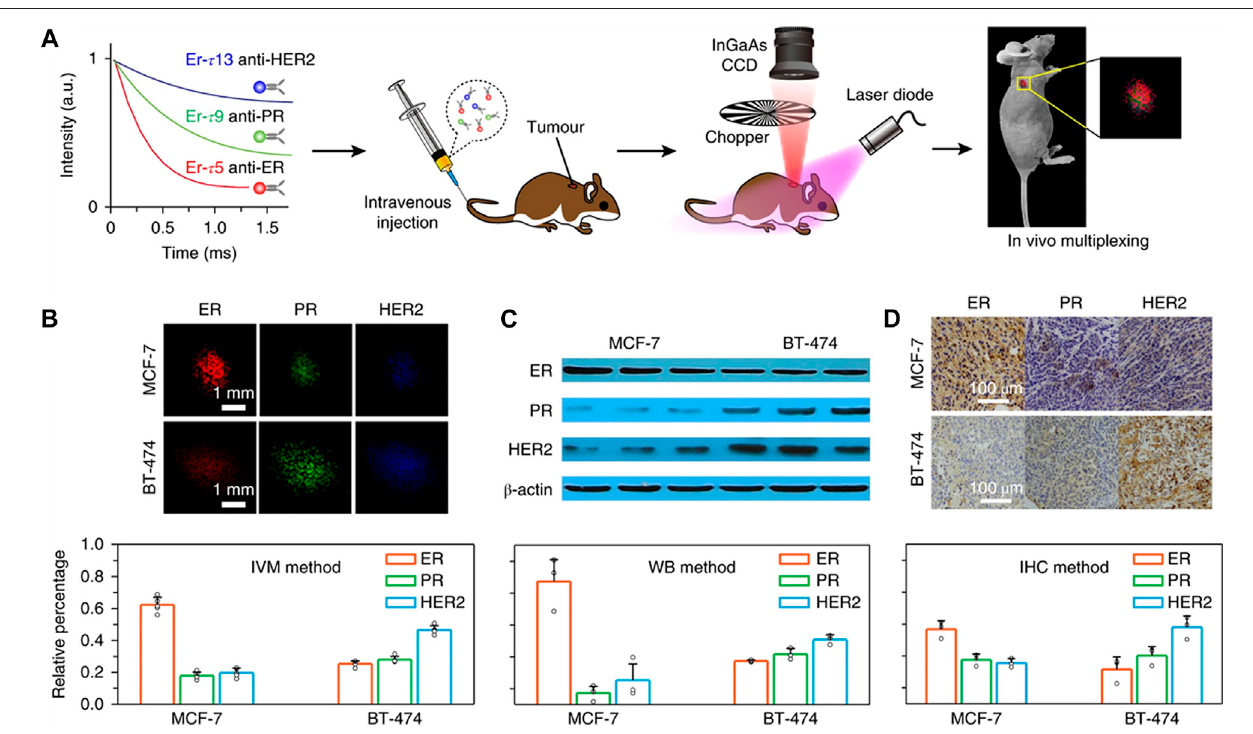
FIGURE 11 | Lifetime-resolved imaging for in vivo multiplexing (IVM) of tumor biomarkers. (A) Schematics illustrating animal experiment procedures. Three batches of Er nanoparticles exhibiting distinct lifetimes are conjugated to three antibodies (anti-ER, anti-PR and anti-HER2), respectively, andintravenously injected into the mouse via tail vein. Lifetime-resolved imaging is then performed to quantify the biomarker expressions on the tumor via IVM. CCD, charge-coupled device. (B) Lifetime-resolved images for the MCF-7 and BT-474 tumors are decomposed into the three lifetime channels, represented by the red, green and blue monochromatic image sets. (C,D) In vitro western blot (C) and ex vivo immunohistochemistry assay (D) results and calculated biomarker expression patterns ofthe two tumors subtypes IVM: in vivo multiplexing; WB: western blot; IHC: immunohistochemistry (reproduced from (Fan et al., 2018) with permission from Springer Nature Publishing